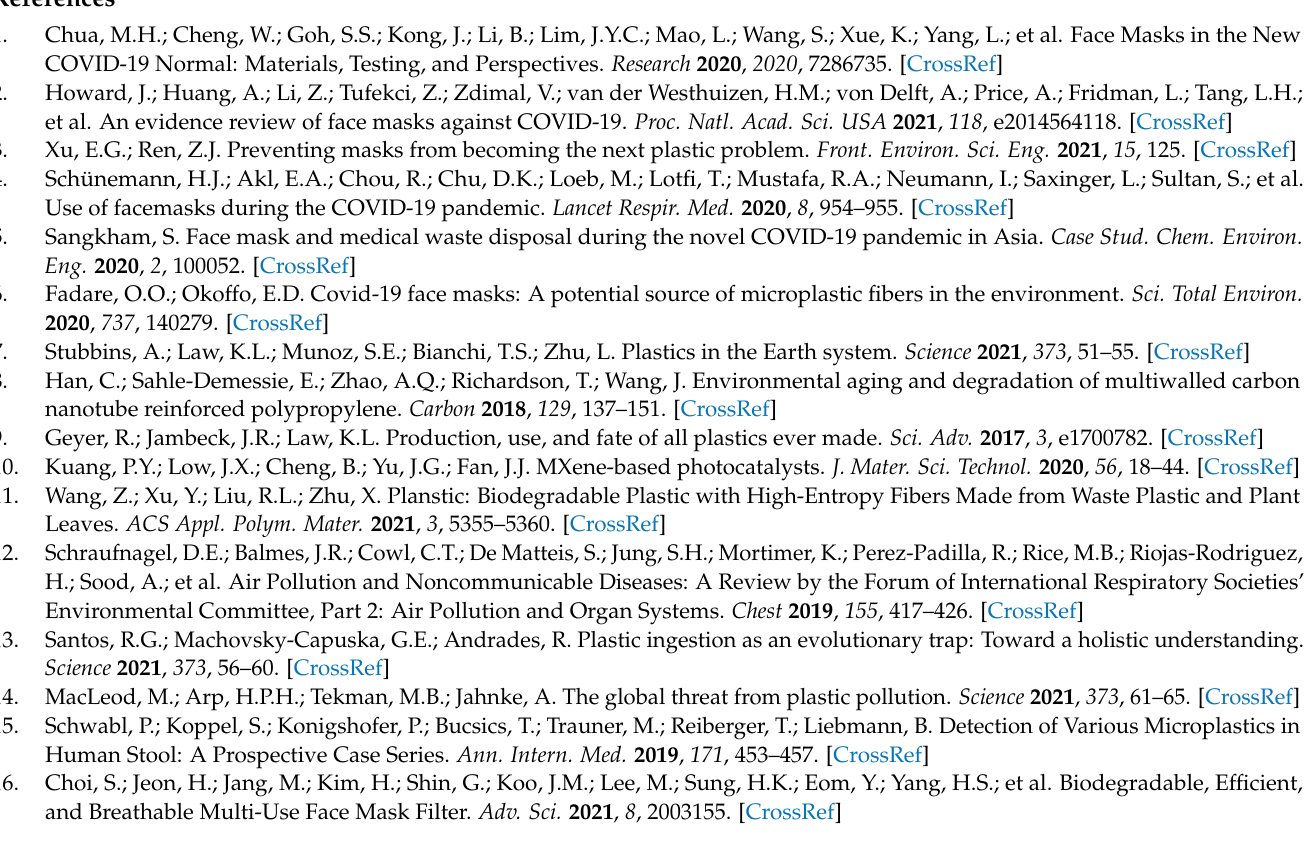
SEM image of Roystonea regia leaf; Figure S7: The appearance and the SEM image of Hymenocallis littoralis leaf; Figure S8: The appearance and the SEM image of bamboo palm leaf; Figure S9: The appearance and the SEM image of Fissistigma oldhamii leaf; Figure S10: The appearance and the SEM image of Semarang rose-apple leaf; Figure S11: The appearance and the SEM image of fishtail palm leaf; Figure S12: The appearance and the SEM image of mango leaf; Figure S13: The appearance and the SEM image of Lagerstroemia indica leaf; Figure S14: The appearance and the SEM image of Chinese Ixora leaf; Figure S15: The appearance and the SEM image of Britton’s wild petunia leaf; Figure S16: The SEM image and size distribution of microplastic in the soil after deg radation of the medical-surgical mask; Figure S17: The relationship between (a) the number of 3D printing layers and air permeability (b) the number of 3D printing layers and filtration efficiency of the TRespirator; Figure S18: Characterization and performance test machines; Table S1: The cost for an N95 mask; Table S2: the diameter, pore size, with mean and maximum pore size respectively, and porosity of the non-woven medical surgical mask, hot air cotton layer of the KN95 mask, and hot air cotton layer of N95 mask; Table S3: the fiber diameter, fiber length, and porosity of 21 kinds of plants; Video S1: 3D-printing process on the mixed